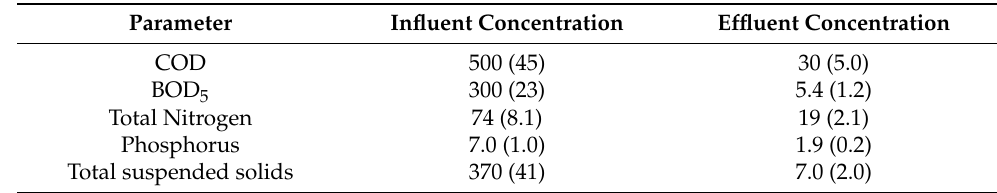
Table 3. Main influent and effluent wastewater characteristics measured during the monitoring campaign (average values and standard deviation, between brackets, in mg/L).